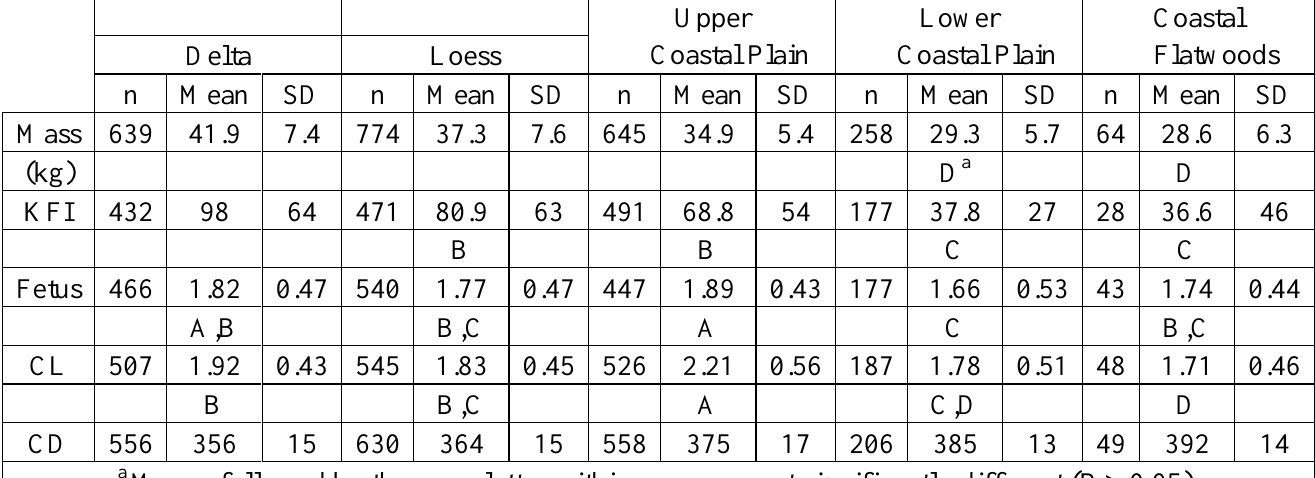
Table 1. Body mass (Mass), kidney fat index (KFI), fetus and corpora lutea (CL) counts, and Julian conception date (CD) for female white-tailed deer from five Mississippi soils in March 1991 – 1998.